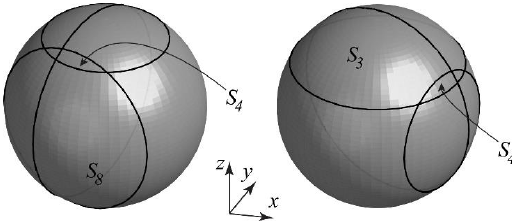
Figure 2. A linear transformation, (𝑥,𝑦,𝑧) ↦ (𝑧,−𝑥,−𝑦) , converts 𝑆 8 to 𝑆 3 without changing the size and shape. The sphere on the left becomes the sphere on the right after the linear transformation. All circles are intersections with 𝑥𝑦 , 𝑦𝑧 , 𝑥𝑧 planes. Note that the surface for 𝑆 8 on the left is in the eighth octant. The same size and shape surface is in the third octant of the sphere on the right after the linear transformation.